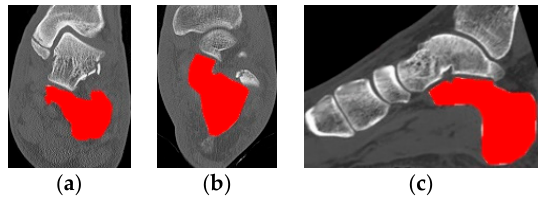
Figure 17. Normal calcaneus segmentation: ( a ) Coronal; ( b ) Transverse; and ( c ) Sagittal.